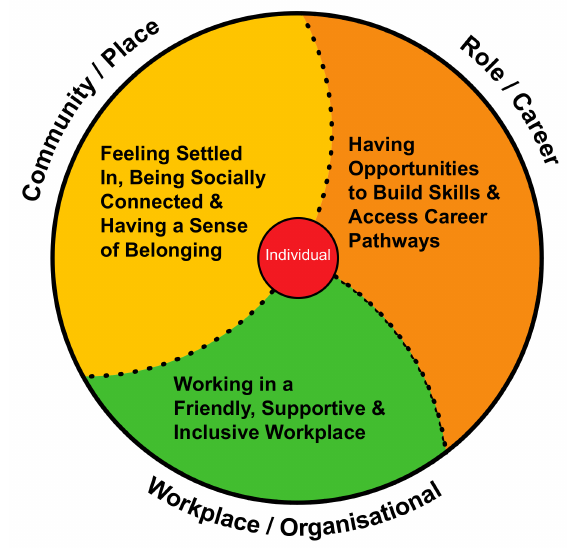
Figure 1. The Whole-of-Person Retention Improvement Framework.